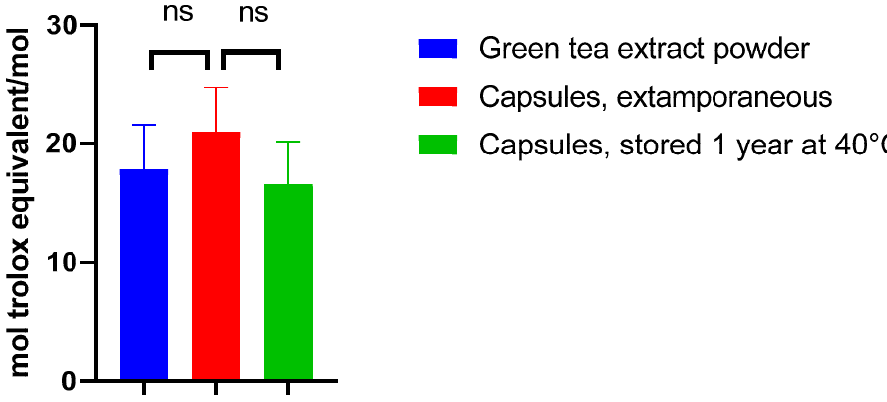
Figure 6. Antioxidant activity expressed in the Trolox equivalent of green tea extract powder of capsules prepared extemporaneously and of capsules stored at 40 °C. capsules prepared extemporaneously and of capsules stored at 40 ◦